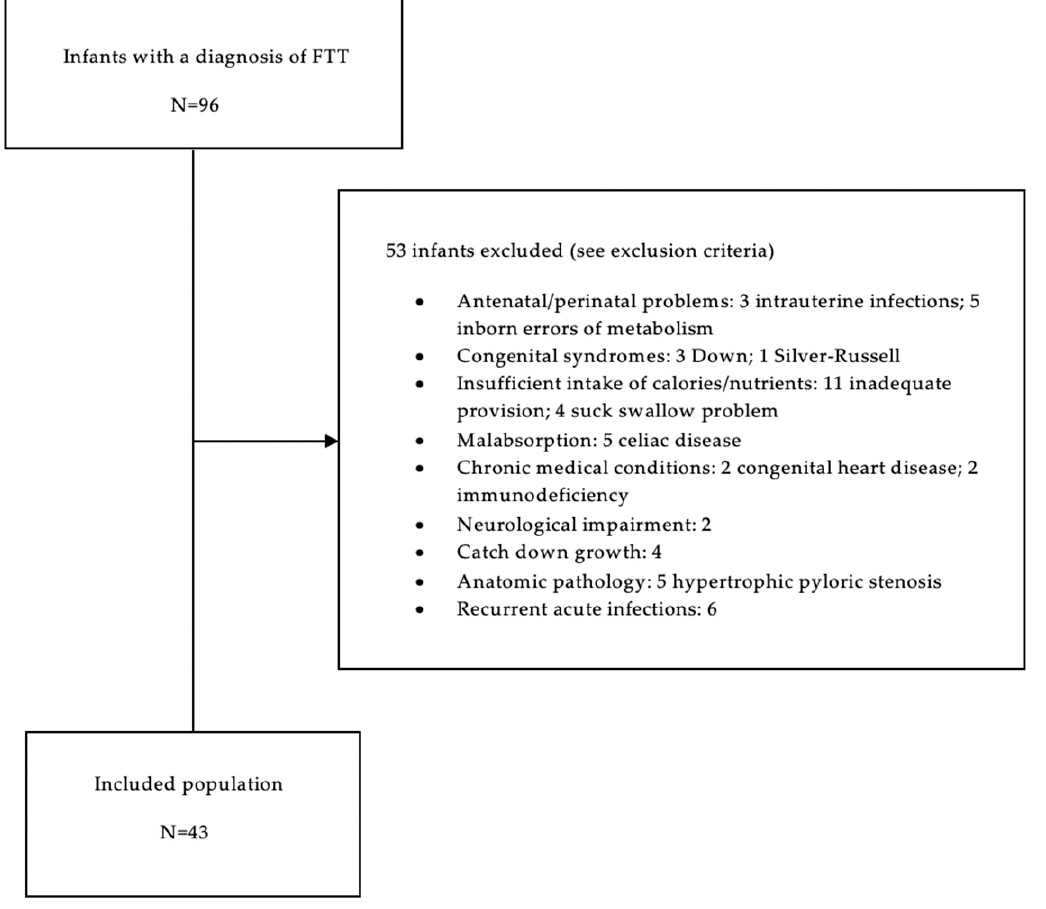
Clinical features, diagnosis, and allergic evaluation of the 43 infants are shown in Table 1.